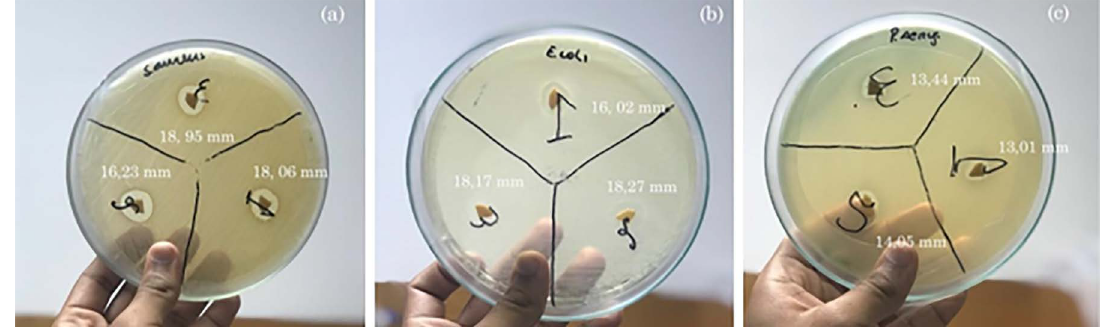
Figure 6. Petri dishes with inhibition halos, after incubation for 24h. (a) MRSA; (b) E. coli and (c) P.